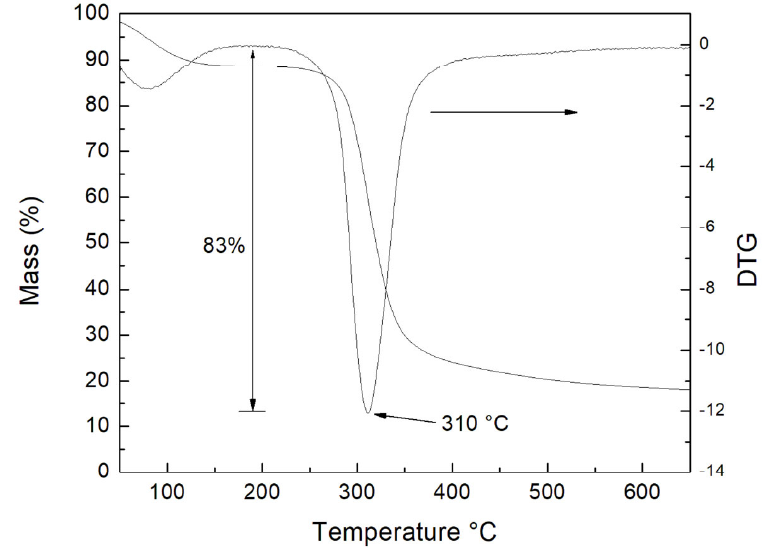
Figure 7. Thermogravimetric analysis of native colok starch.